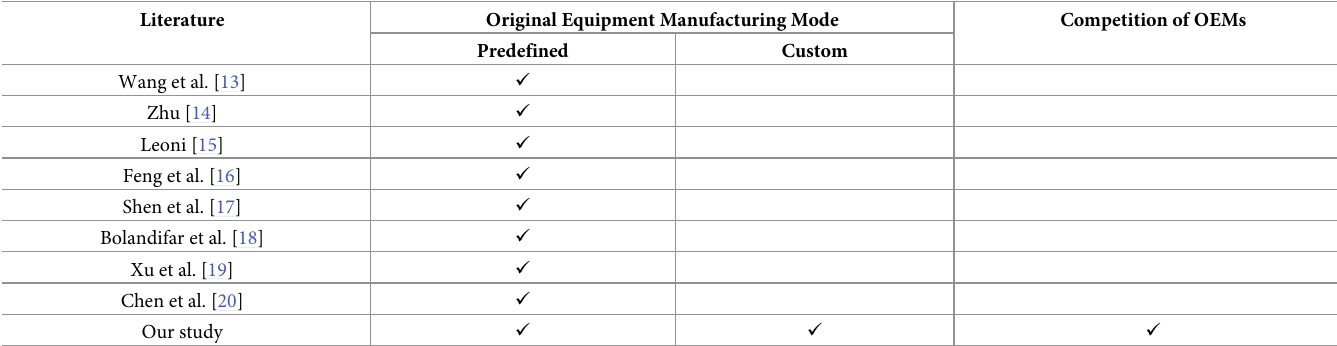
Table 1. Summary of the related literature regarding outsourcing decision-making.